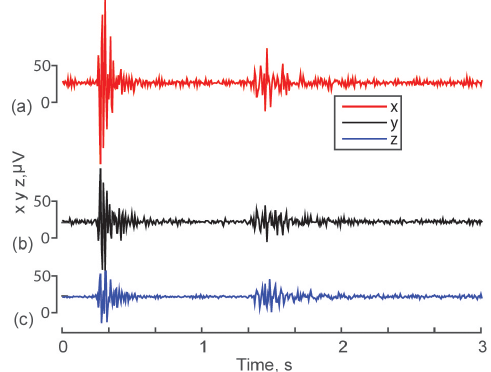
Figure 9. Seismic data acquisition test results in real environmen- tal conditions from the OBEMS at test site R21. (a) First horizontal component, (b) second horizontal component, and (c) vertical geo- phone